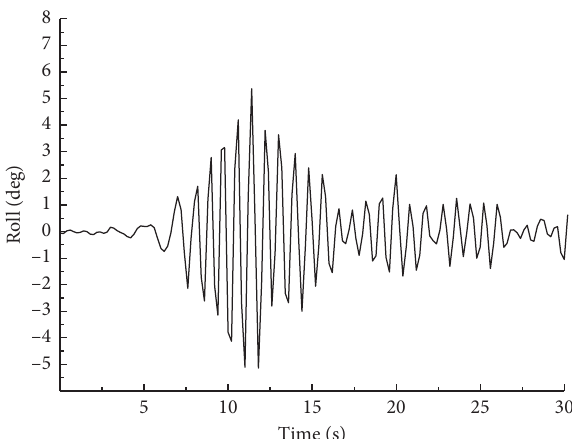
Figure 12: Time history curve of ship roll in curved section.